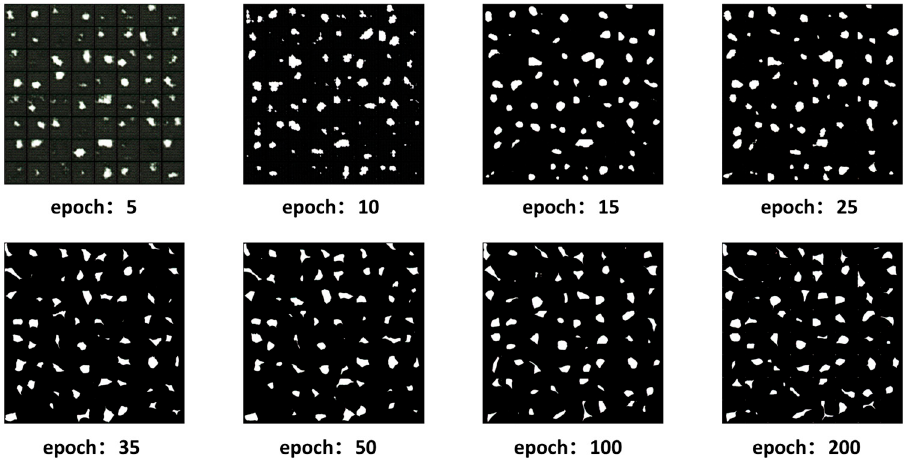
Figure 8. Pothole mask images generated by increasing training